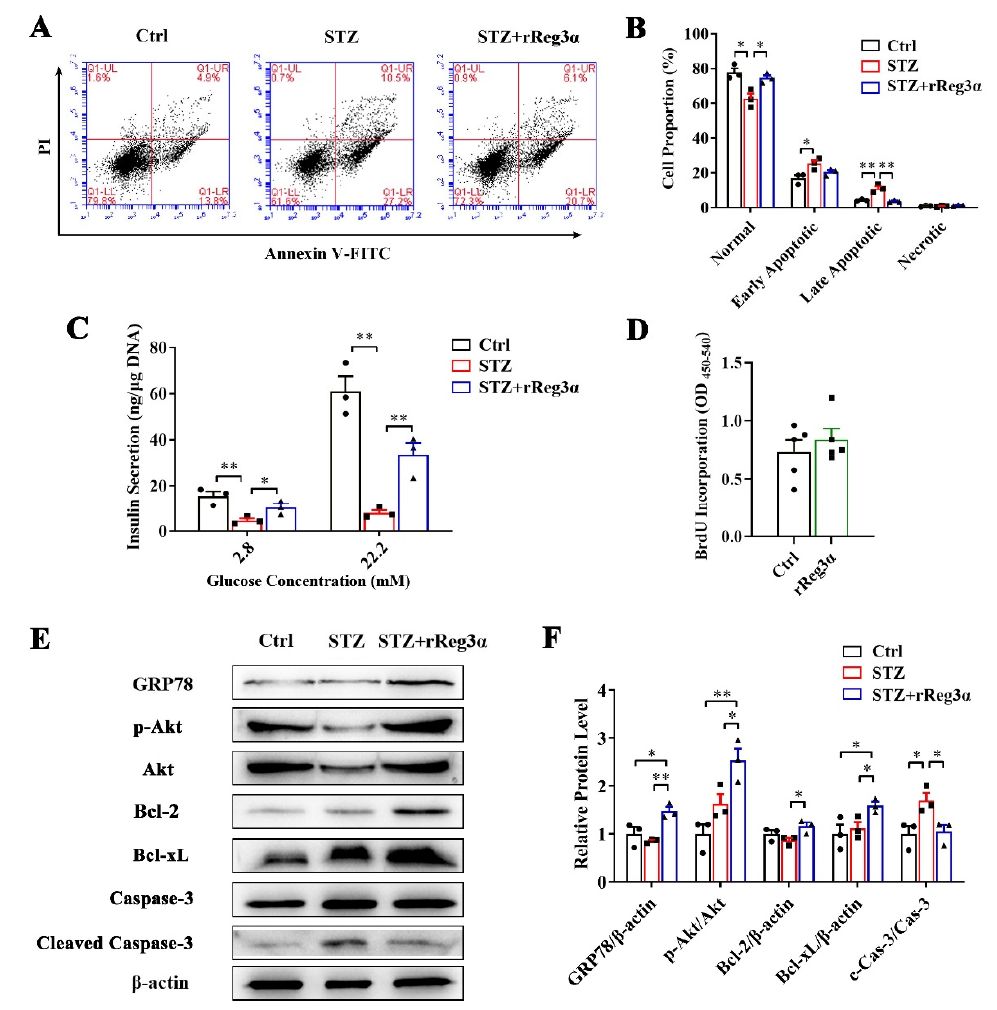
Figure 7. rReg3 α resists STZ-induced cell apoptosis in the isolated islets. ( A ) Apoptotic assessment in the isolated islets treated with rReg3 α prior to STZ. ( B ) Statistics of the cell proportion in panel A. * p < 0.05, ** p < 0.01 using one-way ANOVA, N = 3. ( C ) GSIS assay, * p < 0.05 and ** p < 0.01 using one-way ANOVA, N = 3. ( D ) BrdU incorporation, N = 5. ( E ) Western blotting detection of GRP78, cleaved caspase-3, phosphorylated Akt, and Bcl-2, and -xL levels. ( F ) Densitometric quantification of the protein levels in panel E. The relative GRP78, Bcl-2, and -xL contents were corrected by β -actin and the relative phosphorylated Akt and cleaved caspase-3 contents were corrected by the corresponding total proteins. * p < 0.05 and ** p < 0.01 using one-way ANOVA, N = 3.